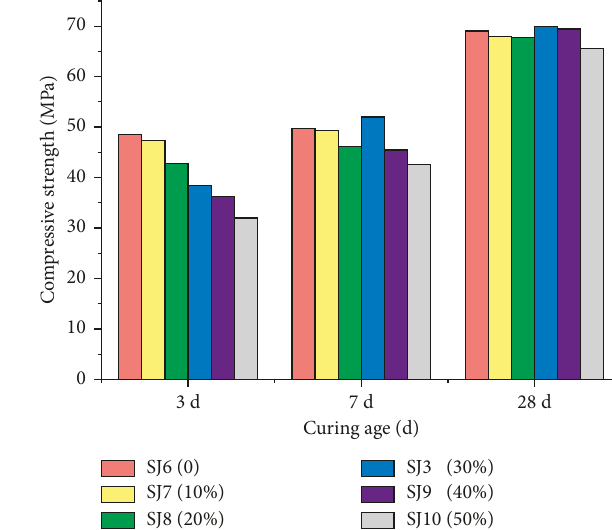
Figure 11: Compressive strength of mortars with different amounts of